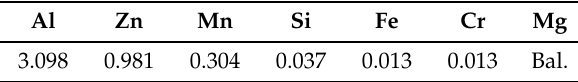
Table 1. Chemical composition of base material (wt. %).